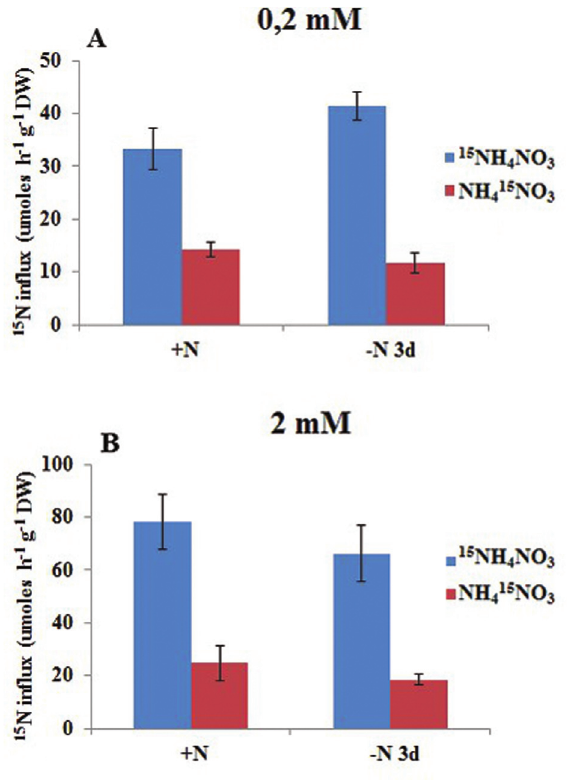
Figure 9 - HATS (A) and LATS (B) under N starvation in C. arabica roots, using ammonium nitrate labeled with 15 N. Details of the uptake ex- periment are described in Material and